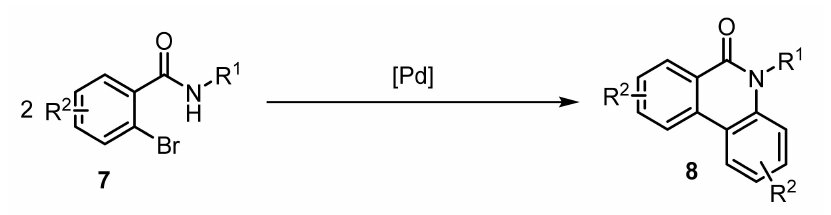
Scheme 4. Palladium-catalyzed homocoupling of 2-bromobenzamides.